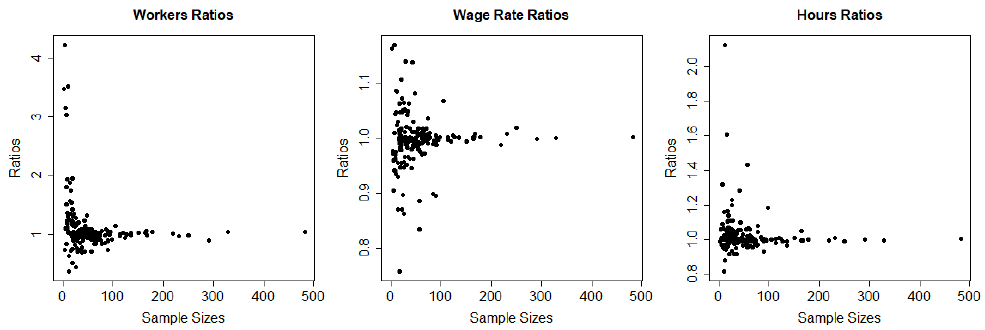
Figure 8. Relative measures of model estimates versus direct estimates for workers, hours, and wage rates in all four worker